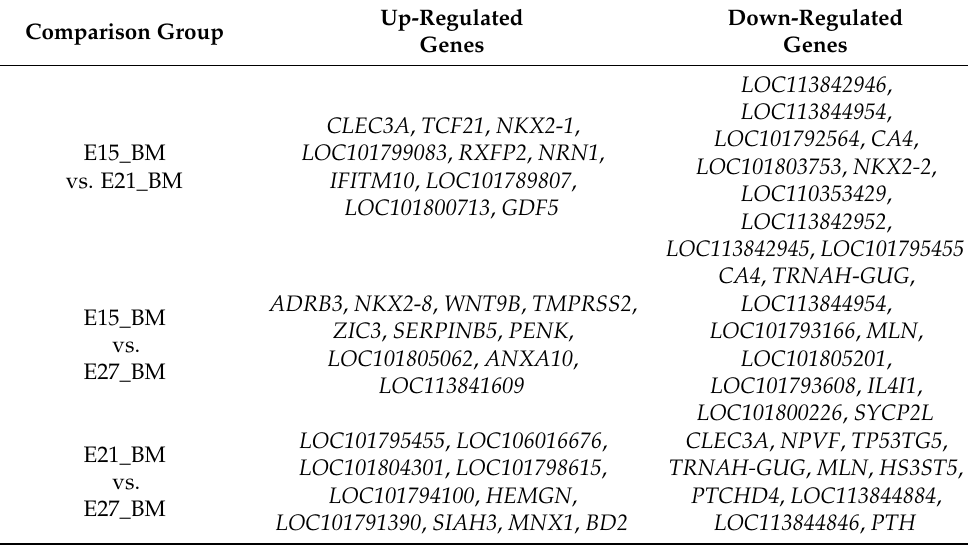
Figure 7. Analysis of differential gene expression. ( A ) Correlation analysis of patterns of gene expres- sion in each group; ( B ) principal component analysis of differentially expressed genes; ( C ) cluster analysis of differentially expressed genes; ( D ) number of differentially expressed genes in each group; ( E ) Venn diagram of co-expression DEGs. Table 2. Top 10 up- and down-regulated genes in each comparison